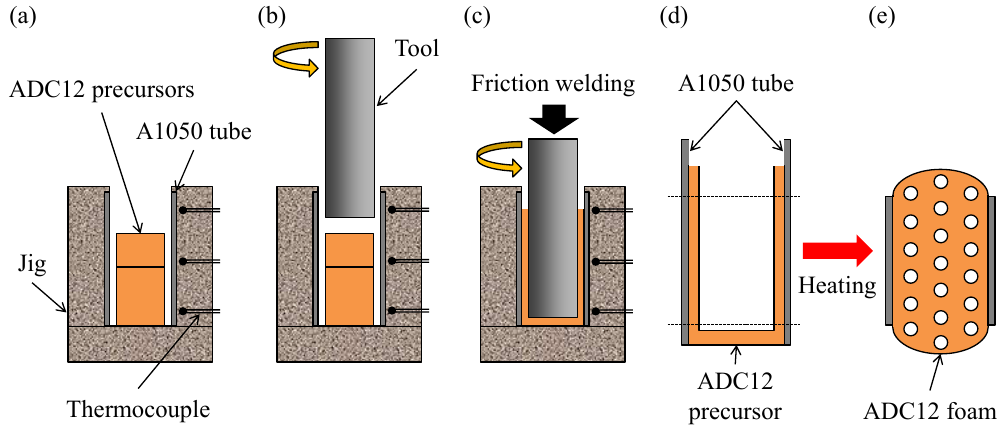
Figure 9. Schematic illustration of fabrication process of ADC12 ‐ foam ‐ filled A1050 tube by friction welding. ( a ) Precursors were set in the tube; ( b ) A rotating tool was inserted into the tube; ( c ) The tool was inserted and friction welding was conducted; ( d ) ADC12 ‐ precursor ‐ bonded A1050 tube was obtained; ( e ) ADC12 ‐ foam ‐ filled A1050 tube was obtained.